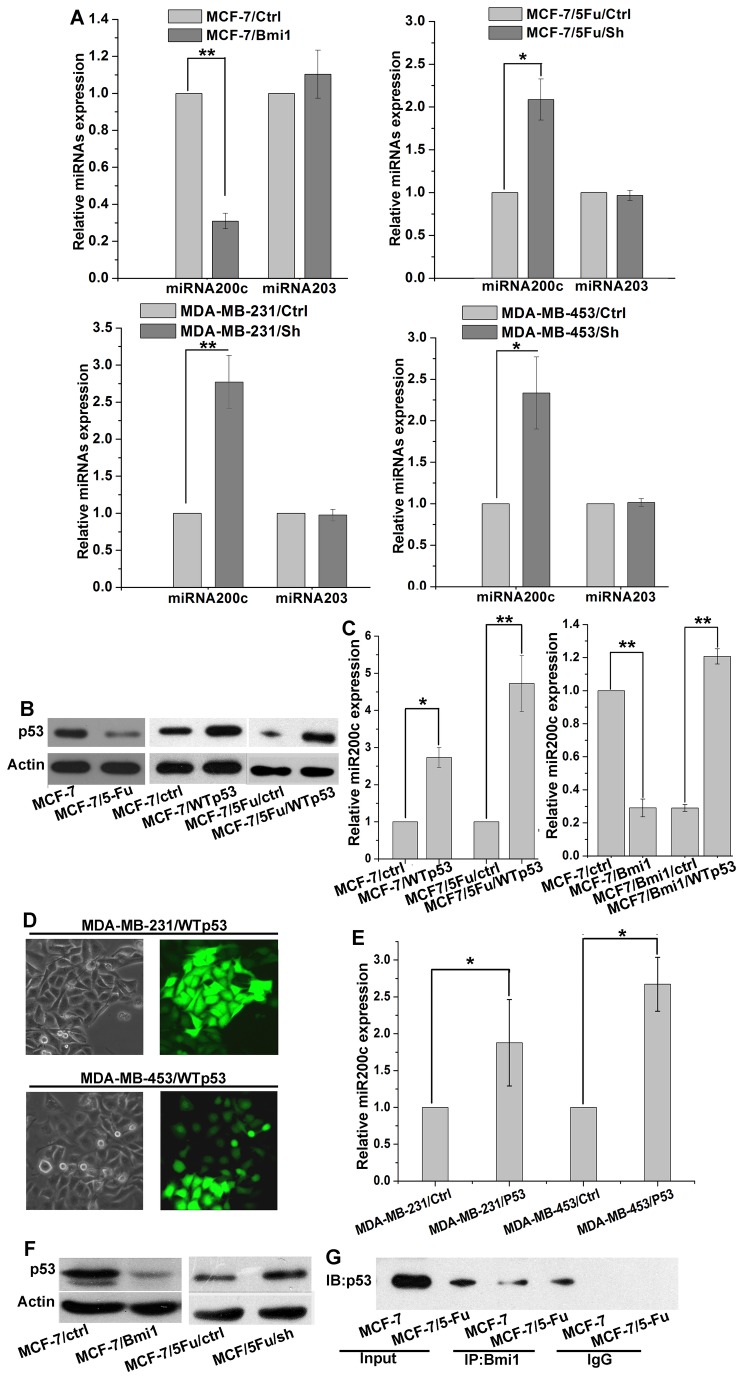
Bmi1 inhibits miR-200c expression via p53 downregulation.(A) the inverse expression pattern between Bmi1 and miR-200c was showed; (B) p53 protein was downregulated in MCF-7/5-Fu cells, and pEGFP-N1-WTp53 transfection increased p53 protein in MCF-7 and MCF-7/5-Fu cells, respectively; (C) WTp53 upregulated miR-200c expression and restored Bmi1 mediated miR-200c downregulation; (D) GFP screen under fluorescence microscope to monitor ectopic WTp53 expression; (E) Ectopic expression of WTp53 upregulated miR-200c in MDA-MB-231 and MDA-MB-453 with mutational p53; (F) Bmi1 negatively regulated p53 protein expression; (G) coimmunoprecipitation showed Bmi1 interacted with p53 physically. All data was obtained from three independent experiments * p<0.05, * p<0.01.